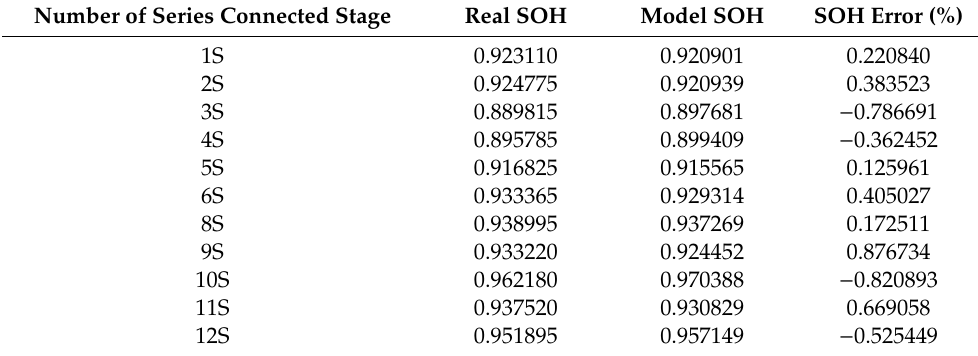
Figure 23. Comparison between the linear regression model based on the partial capacity of cell no.1 and a real SOH based on the partial capacity of the 12 series-connected stages of the retired series / parallel battery pack. Table 3. Numerical results for comparing between the linear regression model based on the IC curve peak point of cell no.1 and a real SOH for the IC curve peak point of the 12 series-connected stages of the retired series / parallel battery pack (SOH error = Real SOH − Model